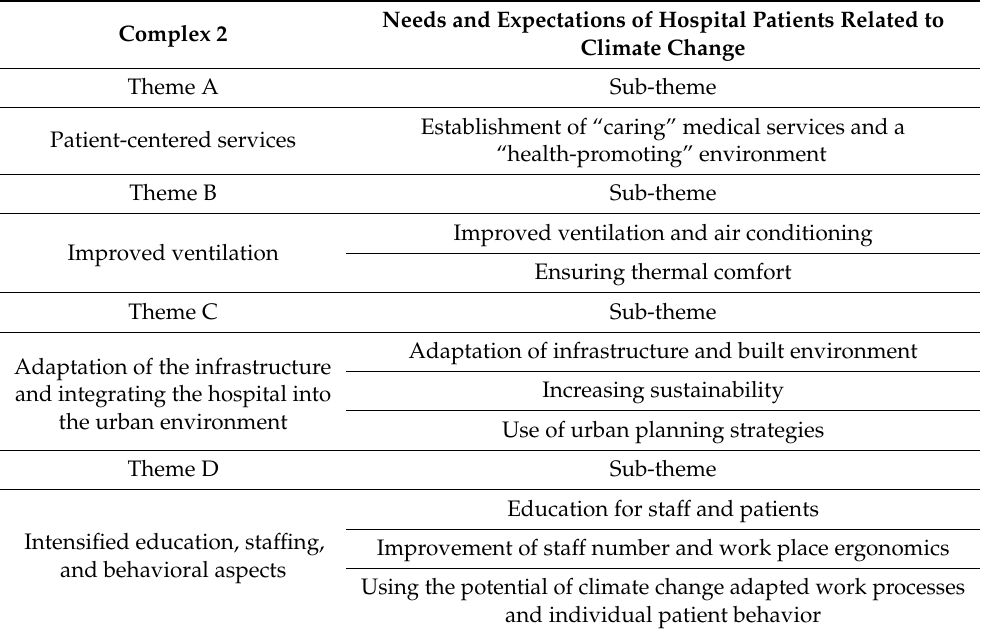
Table 3. Overview of themes emerging from the interviews grouped to complex